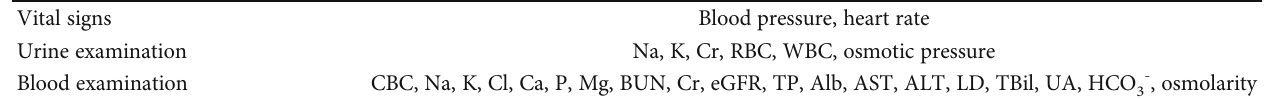
Table 1: Measurement parameters before and after bowel preparation for